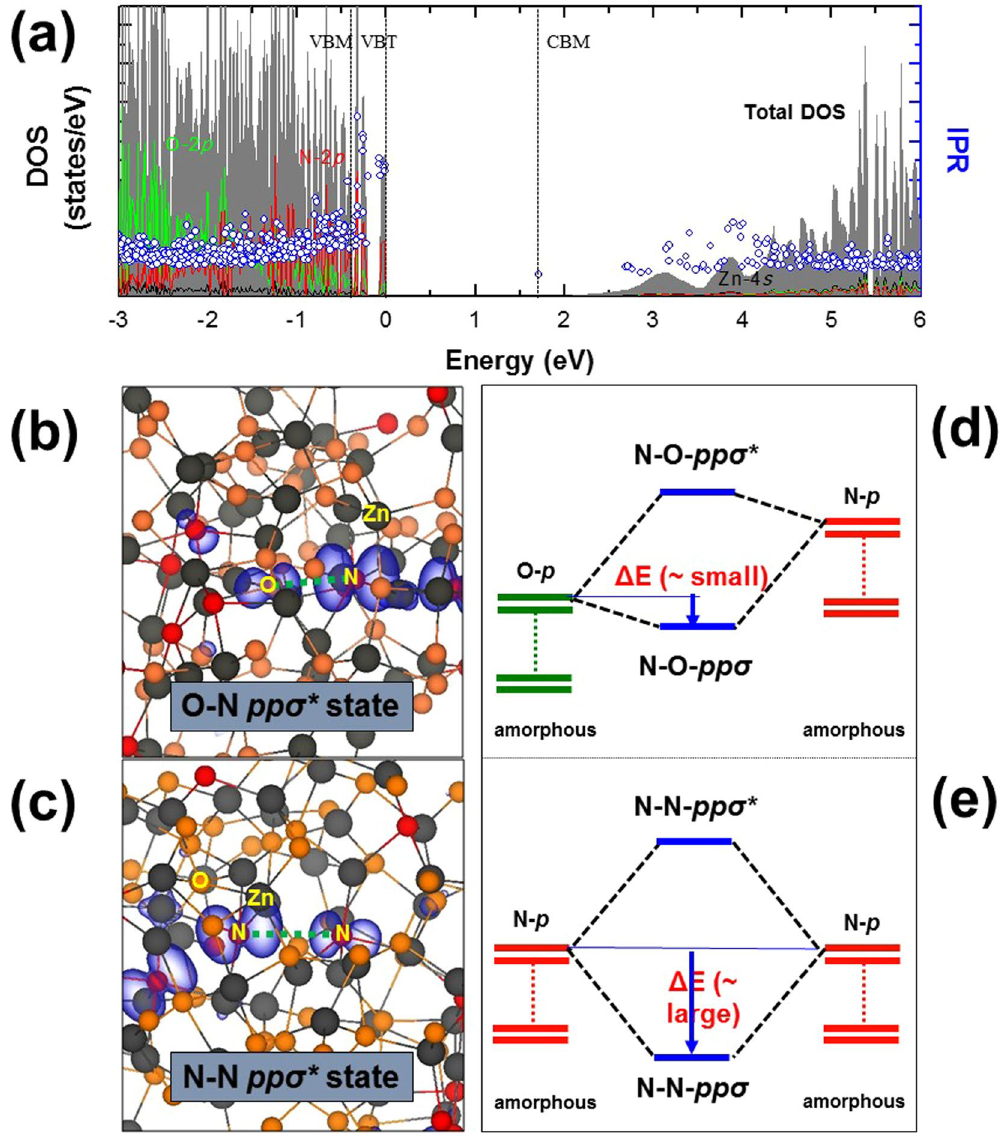
Figure 2. ( a ) For stoichiometric amorphous ZnON with O/N = 1.625 anion ratio as an example, the total density of states (DOS), inverse participation ratio (IPR) (indicating the degree of electronic localization), and partial DOS (PDOS) for O-2 p , N-2 p , and Zn-4 s are shown. Because it is difficult to determine both the valence band maximum (VBM) and valence band tail (VBT) states of amorphous ZnON without being able to consider a crystalline ZnON structure as reference, the VBM and VBT distributions were evaluated through the analysis of the high inverse participation ratio (IPR) values near the top valance bands. For ( b ) the N-O pp σ * and ( c ) the N-N pp σ * states, charge density plots of the top valence band states in amorphous ZnON are shown with an isosurface value of 1.25 × 10 − 5 Å − 3 . The green dotted line is a bond direction along which a dimer is formed when two holes are captured at the top valence band state. Schematic formation mechanisms for the character of the top valence band states in amorphous ZnON are also shown for ( d ) the N-O pp σ * and ( e ) the N-N pp σ * states. Δ E indicates the energy gain by the anion-anion